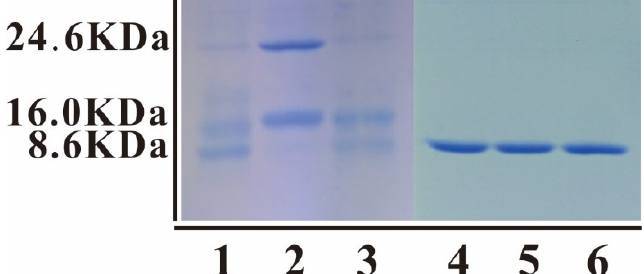
Figure 4. Enterokinase cleavage of fusion mNKLs: 1 , 2 and 3 were cleaved trxA ‐ mNKL 1, trxA ‐ mNKL 2 and trxA ‐ mNKL 3, including not cleaved recombinant proteins (approximately 24.6 KDa), His ‐ tagged Trx (approximately 16.0 kDa) and mNKLs (approximately 8.6 kDa); 4 , 5 and 6 were purified and concentrated mNKL 1, mNKL 2 and mNKL 3, respectively.